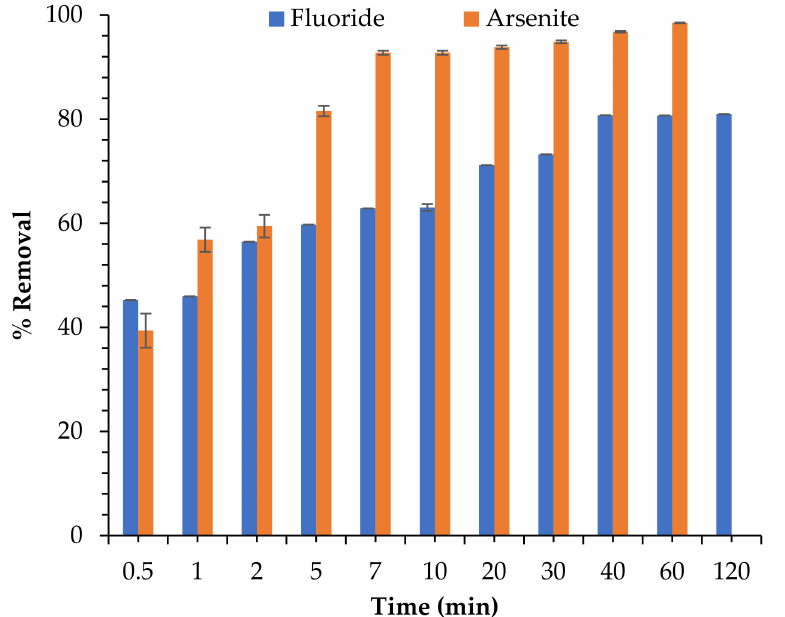
Figure 6. The significance of contact time on F − and As 3+ sorption using Fe-pPD. (Initial F − and As 3+ concentration: 5 and 10 mg/L, respectively; adsorbent dose: 0.4 g; solution volume: 50 mL; shaking speed: 250 rpm at 297 K).